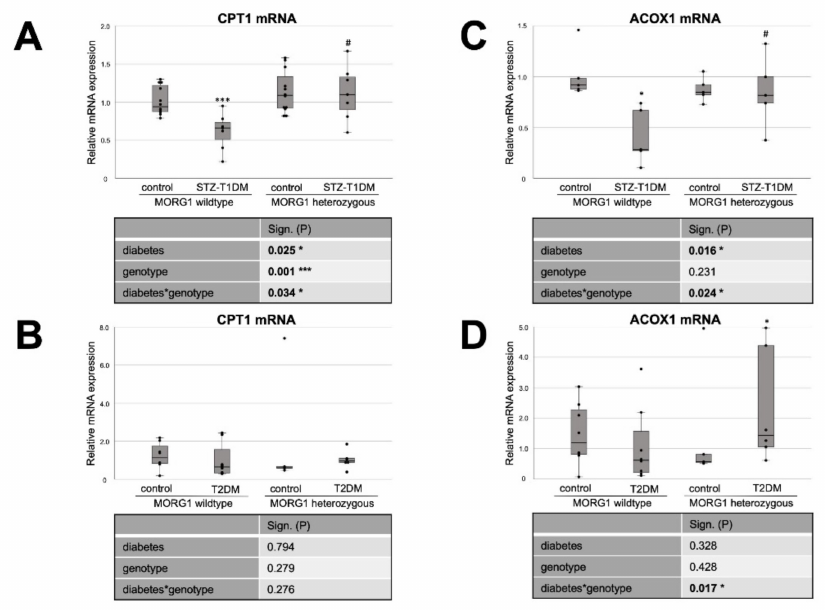
Figure 5. MORG1 effect on expression of key enzymes of FAO (fatty acid oxidation) in diabetic kidneys. ( A , B ) Real-time analysis of CPT1 (carnitine palmitoyl transferase 1) mRNA expression in STZ-T1DM and T2DM. ( C , D ) Real-time analysis of ACOX1 (Acyl-CoA Oxidase 1) mRNA